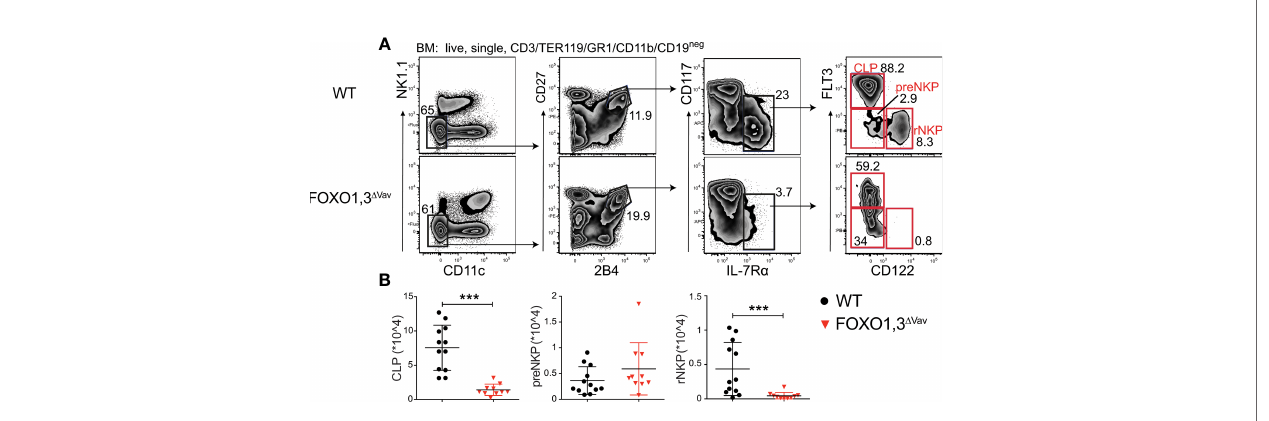
FIGURE 4 | FOXO de fi ciency results in a block at the preNKP to rNKP transition. (A) Representative fl ow cytometry pro fi les showing the identi fi cation of CLP, preNKP and rNKP in animals with the indicated genotype. (B) Total number of CLP, preNKP and rNKP in BM of animals with the indicated genotype ( n = 10-12). In panel (B) : dots represent individual analyzed animals; p-values were calculated using Mann-Whitney; bars indicate mean and SD; *** indicates p-values